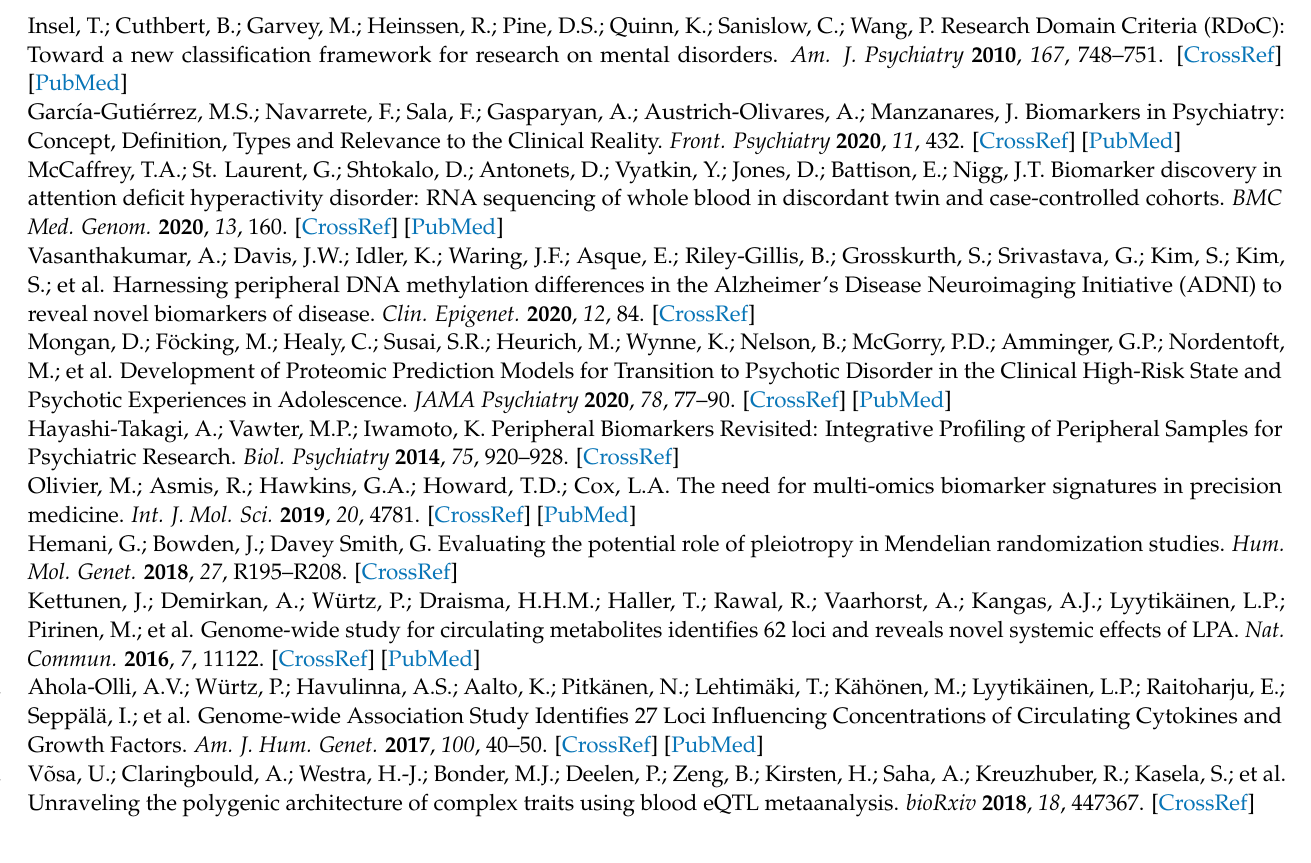
Table S9 Simulation analysis for BP. Supplementary Table S10 summary of results of real data analysis. Supplementary Table S11 Summary and comparison of blood multi-omic biomarkers. Supplementary Figure S1 Flowchart and data summary of the study. Supplementary Figure S2 summary of SMR HEIDI( − ) results for each omic and disease. Supplementary Figure S3 methylation markers and its biological interpretation. Supplementary Figure S4 Step-wise outlier removal test for Bis.DB.ratio. Supplementary Figure S5 Simulation analysis of AN markers. Supplementary Figure S6 Simulation analysis of AD markers. Supplementary Figure S7 Comparison of HEIDI(+) and HEIDI( − ) markers in real-world data. Supplementary Figure S8 Diagnostic model of PD by methylation markers. Supplementary Figure S9 Diagnostic model of BP by RNA markers. Supplementary Figure S10 Validation of methylation diagnostic markers of